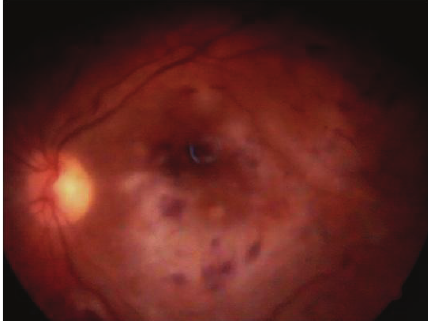
Figure 3: Gram-positive thin long beaded branching filaments of Nocardia.